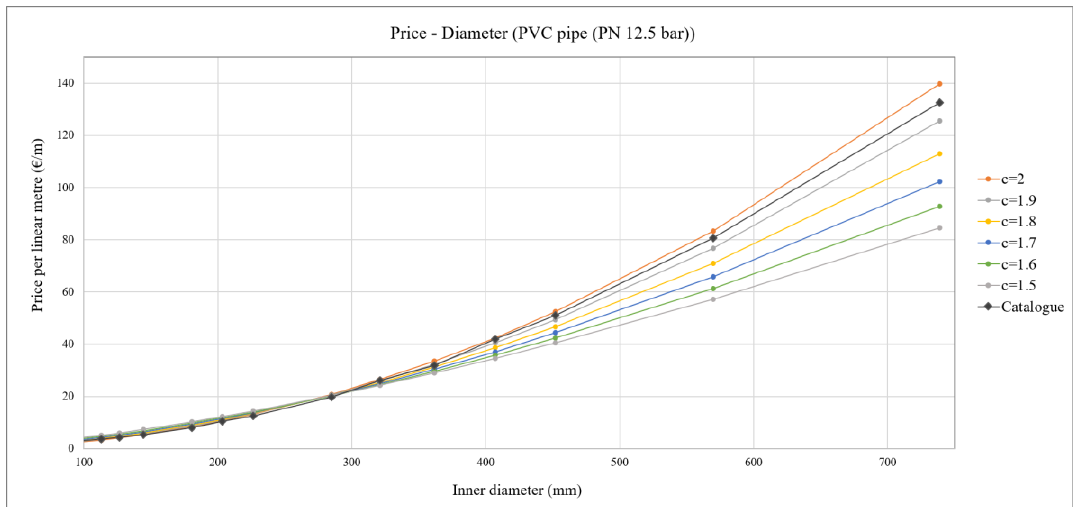
Figure 3. Adjustment c p = a 0 (p)·D c according to c .